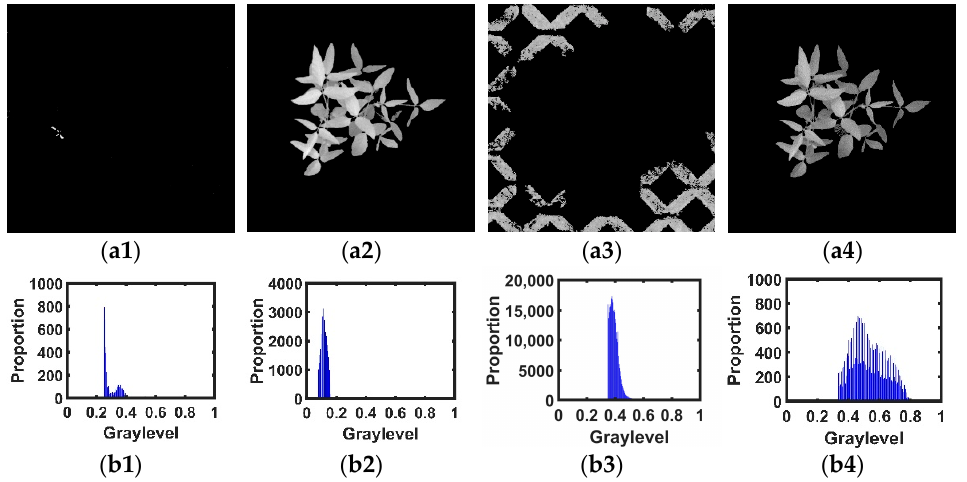
Figure 9. Extraction effect and corresponding histograms of the soybean canopy under normal treat- ment: ( a1 ) GRE target image, ( a2 ) NIR target image, ( a3 ) RED target image, ( a4 ) REG target image, ( b1 ) GRE histogram, ( b2 ) NIR histogram, ( b3 ) RED histogram and ( b4 ) REG histogram.